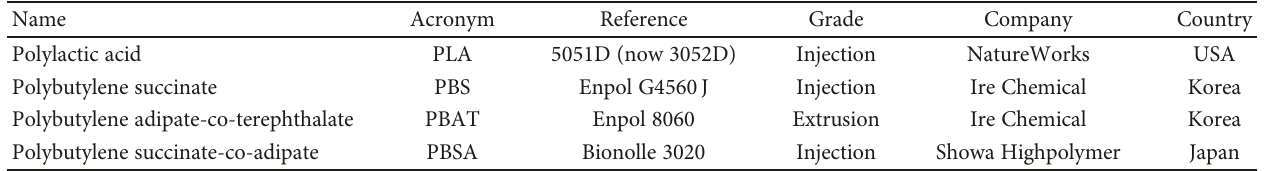
Table 2: Biopolyesters used in this study.